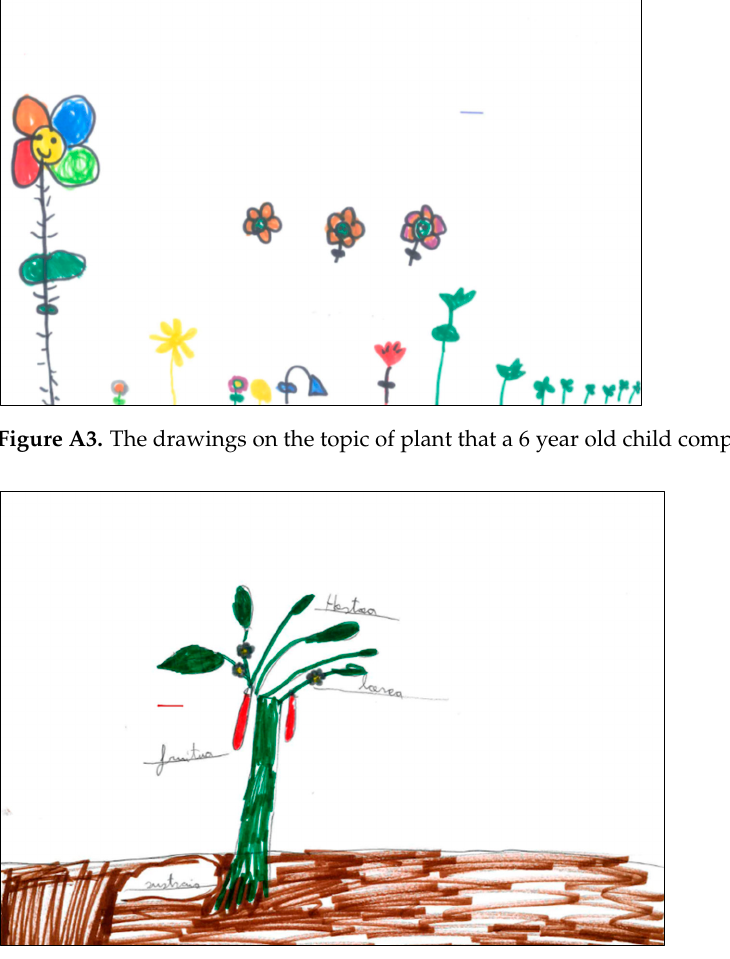
Figure A4. The drawing on the topic of plant that the same child indicated in Figure A3, completed in 2021.